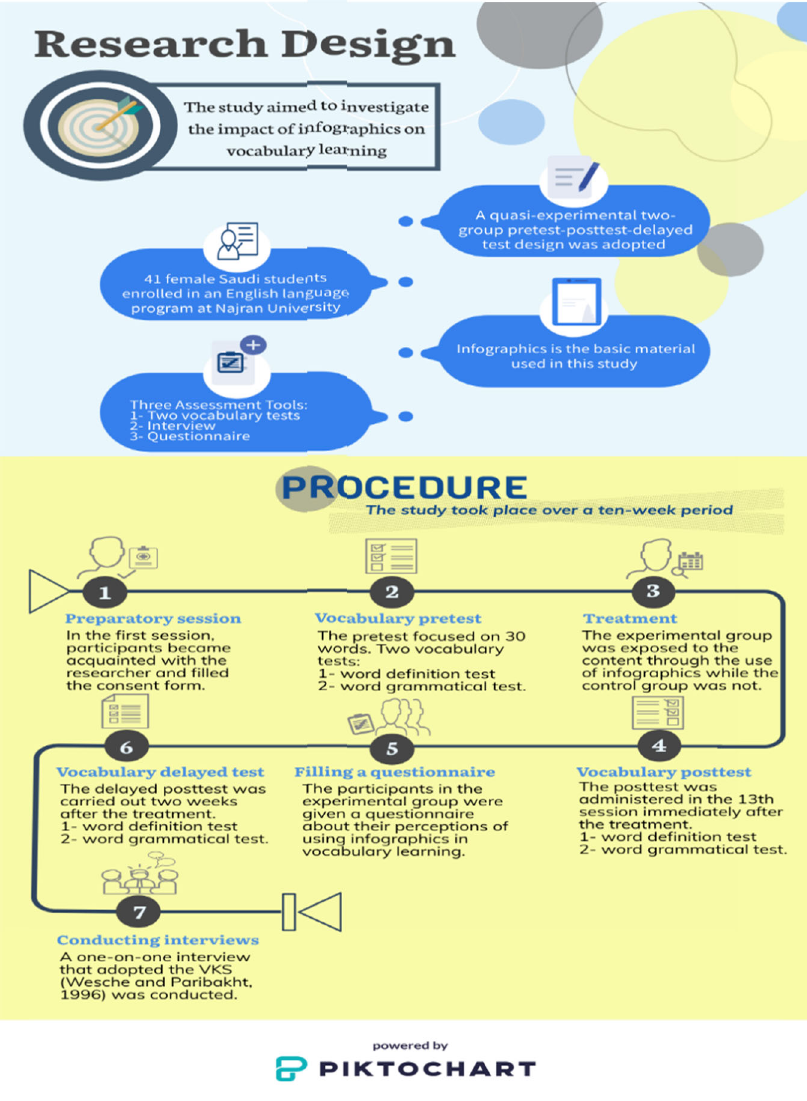
Fig. 3 Flowchart of the study design and procedure.